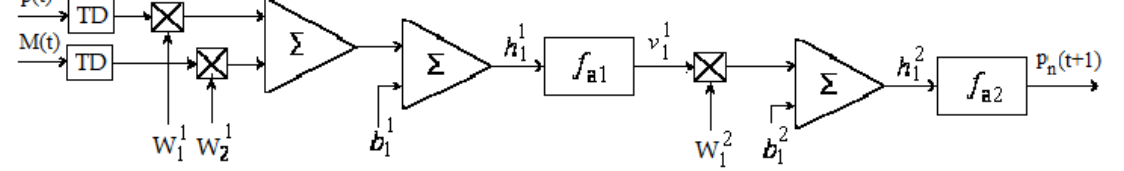
Figure 14. The structure of the feedforward neural network.